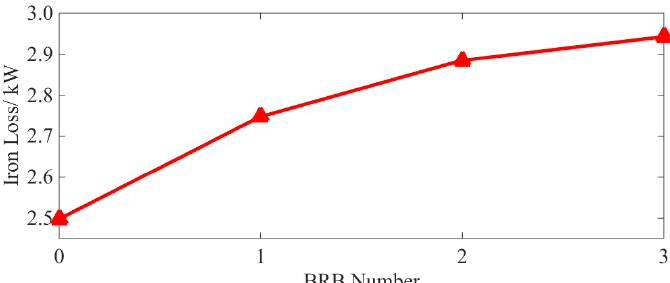
Figure 11. Characteristic curve of iron loss.